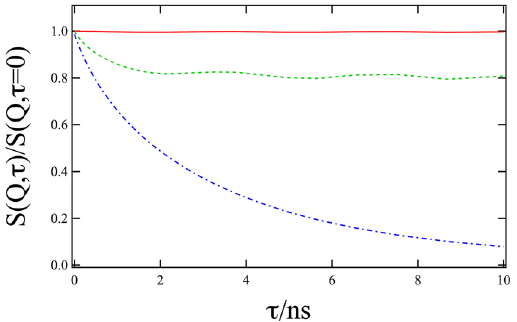
Figure 2. Calculation of the intermediate scattering function S(Q, t) with the Romanov model. The relaxation and oscillation of S(Q, t) is very sensitive to the in plane part, here with Q || = 5.5 × 10 − 3 Å − 1 (solid red line), 11 × 10 − 3 Å − 1 (dashed green line), 16.5 × 10 − 3 Å − 1 (dash-dotted blue line). All other parameters were kept constant at the values extracted from the fit to the data shown in Fig.